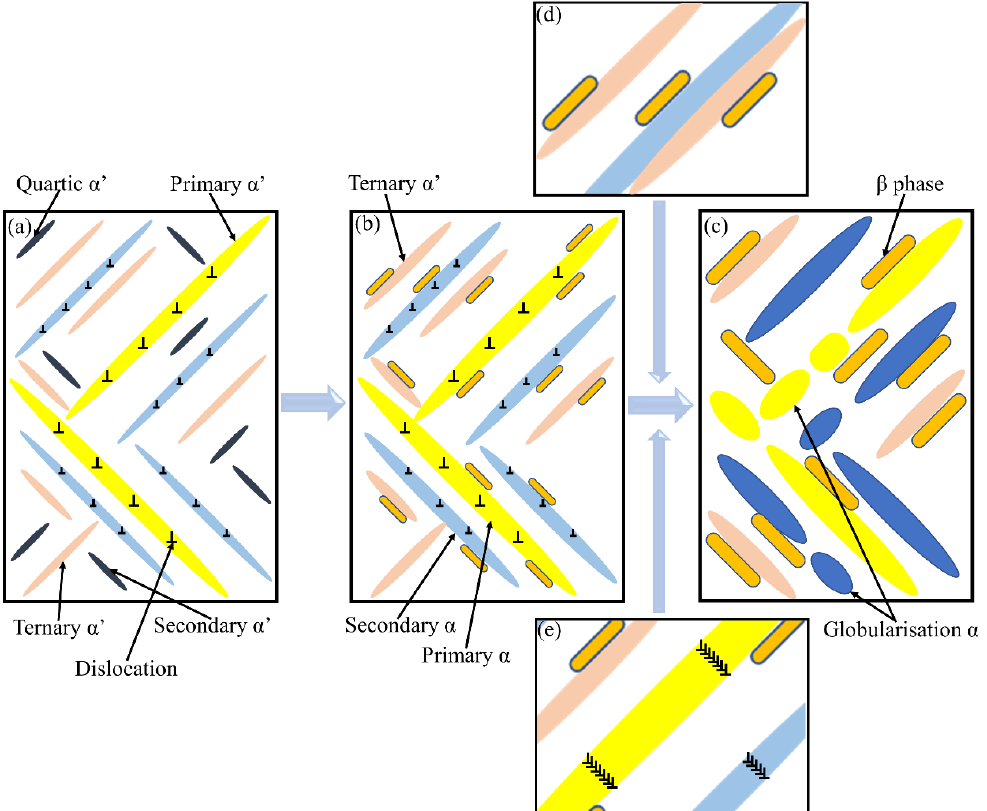
Figure 9. Schematic diagrams of the ( a ) α’ martensite hierarchical structure, ( b ) microstructure after low-temperature annealing and ( c ) microstructure after high-temperature annealing. ( d ) The coarsening and growth of the lamellar grains, ( e ) formation of early sub-grain boundaries.